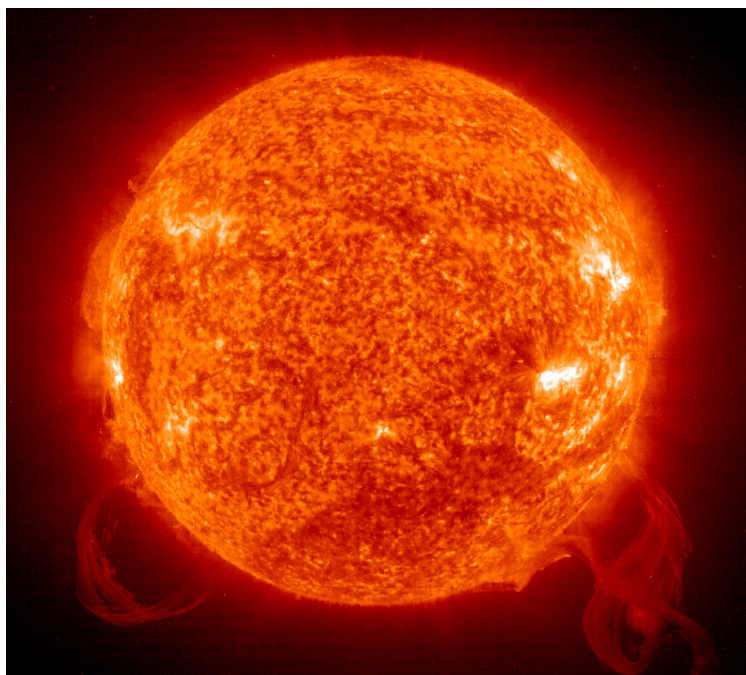
Figure 4. This SOHO image taken on 18 March 2003 shows, in the helium line He II 30.4nm emitted at a temperature of about 60–80kK, the chromospheric network on the solar disk and two huge prominences off the solar limb. Prominences often are at the origin of the solar eruptions that drive coronal mass ejections (CMEs). The magnetic network has typical cell sizes of 20–30Mm, with strong magnetic fields of about 100G concentrated in the network lanes, and spreads rather uniformly over the entire solar disk